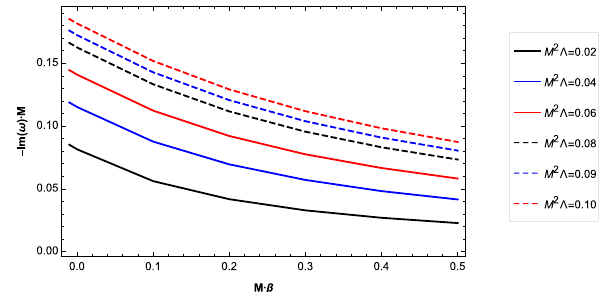
Fig. 7 The behavior of the fundamental dS mode ( n dS = 0) − Im (ω) M as a function of M β obtained by using the pseudospectral Chebyshev method for massless scalar field with (cid:5) = 1 and different values of the cosmological constant